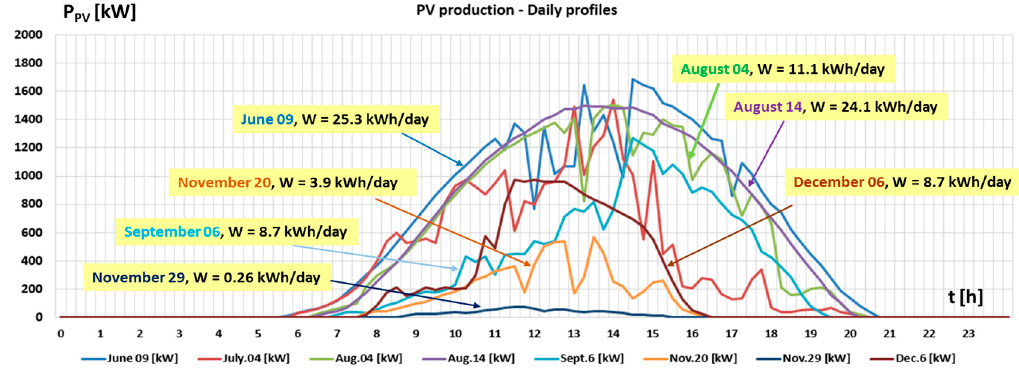
Figure 5. Electricity generation from a 2 kWp PV installation on representative days across the year.